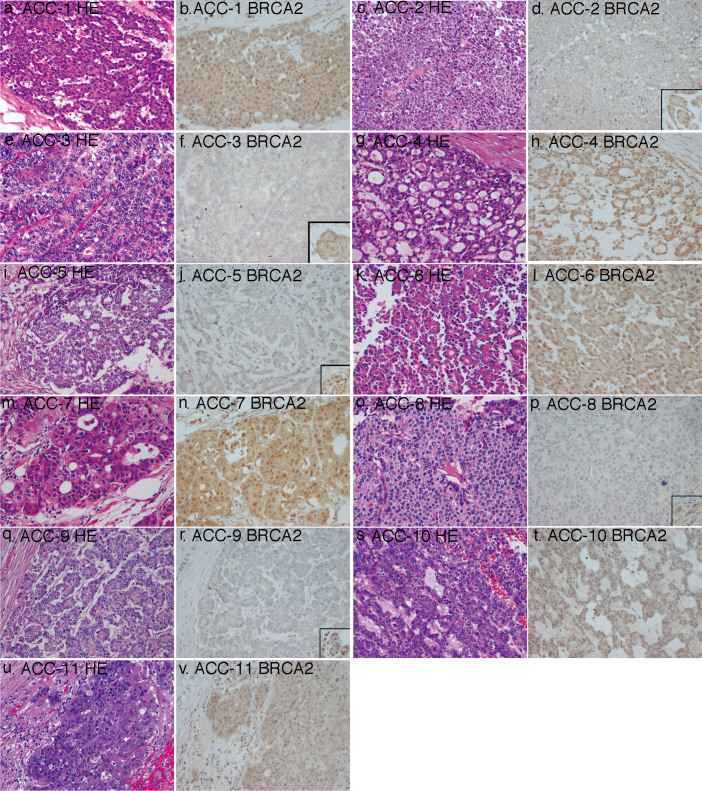
Immunohistochemical examination of the expression of BRCA2 in acinar cell carcinoma. Insets in panels d, f, j, p, and r show positive staining in normal acini in the same slide. HE, hematoxylin and eosin staining. Original magnification ×200.